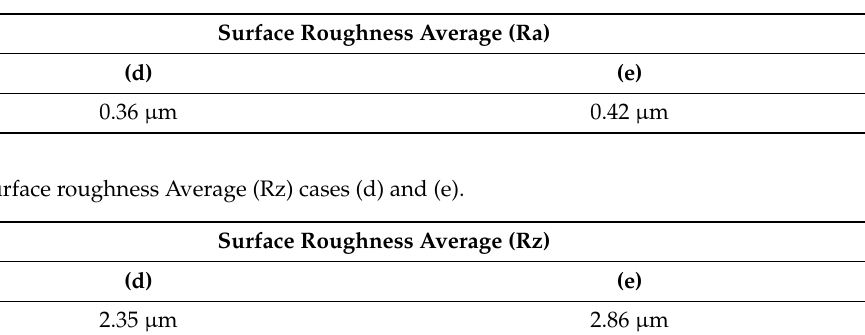
Table 5. Surface roughness average (Ra) cases (d) and (e).